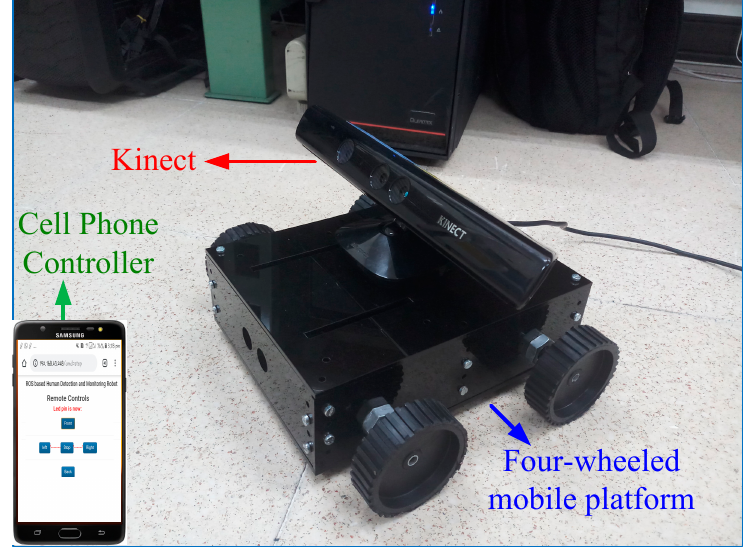
Figure 7. Experimental setting: The four-wheeled mobile platform equipped with a Kinect device and controlled wirelessly by a cell phone with a control interface.